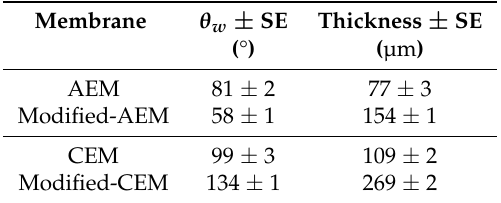
Table 1. Ultrapure water contact angle ( θ w ) and membrane thickness values for the ion exchange membranes (IEMs) synthesized in this work (SE n = 10).